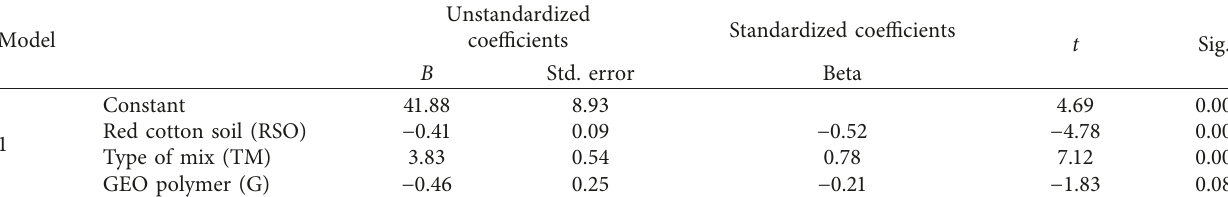
Table 4: Coefficients of mud block using red soil with